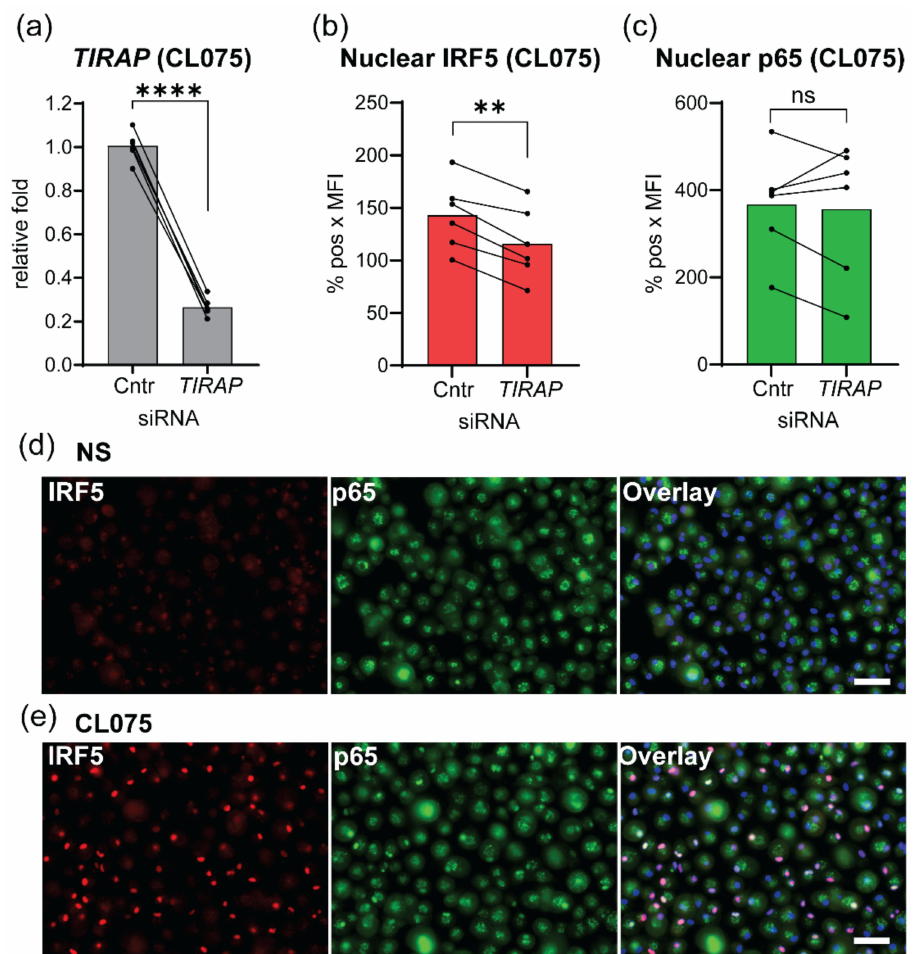
Figure 4. Silencing of TIRAP gene inhibits nuclear translocation of IRF5 in 60 min after CL075 stimulation. Experiments were performed on human MDMs ( n = 6 donors). ( a ) TIRAP -silencing efficacy was quantified with RT-qPCR from parallel wells of CL075 stimulated cells using non- stimulated cells for normalization (fold = 1.0). Control or TIRAP -silenced cells were stimulated with CL075 (2 µ g/mL) for one hour, followed by fixation of cells, double staining of IRF5 ( b ) and NF-kB (p65/RelA) ( c ), DNA staining by Hoechst 3342 for nuclei visualization, and quantitative imaging by high-content screening (Olympus ScanˆR system). The level of nuclear IRF5 ( b ) and p65 ( c ) was calculated as the percentage of positively stained nuclei multiplied by the mean fluorescence- intensity value (MFI) of the positively stained nuclei. In non-stimulated cells, the background-staining levels (%pos × MFI) for nuclear IRF5 and p65 were <15 and <73, respectively. ( d , e ) Representative immunofluorescent images of non-stimulated (NS) and CL075 stimulated cells used for quantification of IRF5 (red channel) and p65 (green channel) in nuclei (blue channel). Scale bar shown in overlay represents 50 µ m. Statistical significance was examined with paired t -test (** p < 0.01, **** p < 0.001). Phosphorylation of IRFs and other transcription factors typically reflect their active state and is linked to their nuclear translocation and the activation of transcription of target genes [37,38]. To evaluate the potential regulation of IRF5 phosphorylation by TIRAP, we performed electrophoresis using Phos-tag gel [39] (Figure S4), since efficient phospho-IRF5 antibodies are not commercially available. Lysates of LPS-stimulated cells were included as a negative control since TLR4 signaling does not trigger IRF5 translocation in human MDMs, but rather it activates the IRF3-transcriptional factor in a TRAM/TRIF- dependent manner [13,26,40]. No clear alterations in the phosphorylation pattern of IRF5 or p65 in TIRAP -silenced cells after CL075 stimulation were revealed (Figure S4).